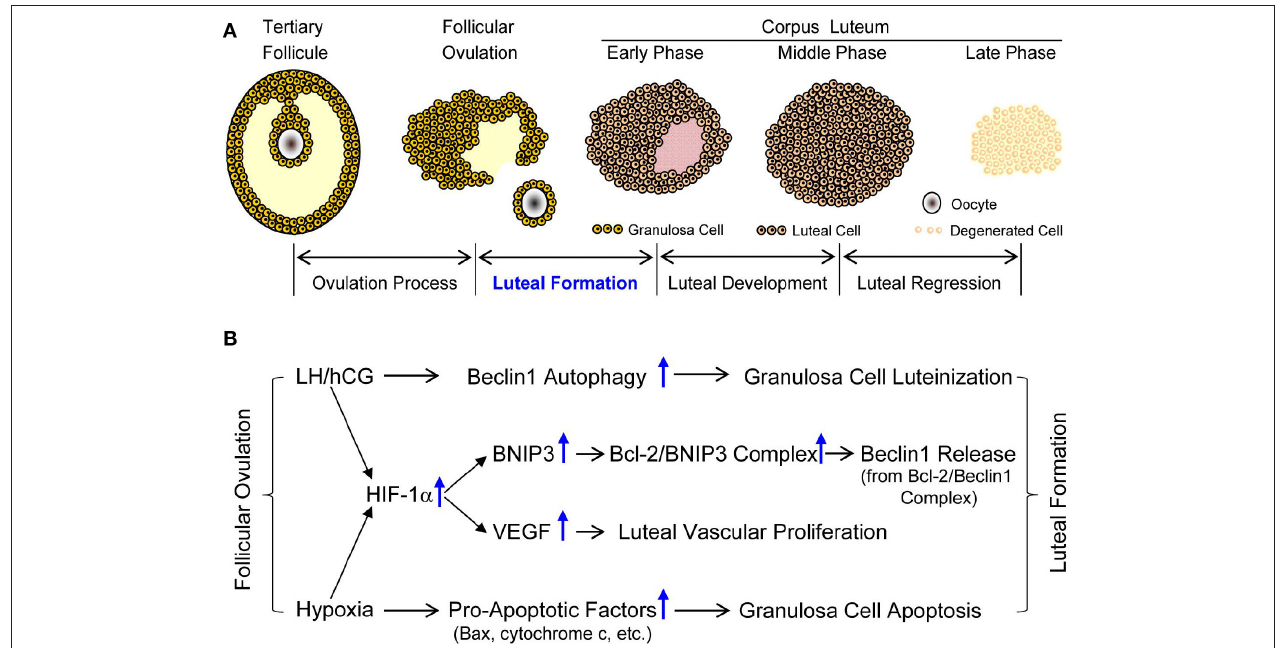
FIGURE 13 | Developmental phases of corpus luteum and possible mechanism of luteal formation. (A) Developmental phases of corpus luteum. (B) Possible mechanism of luteal